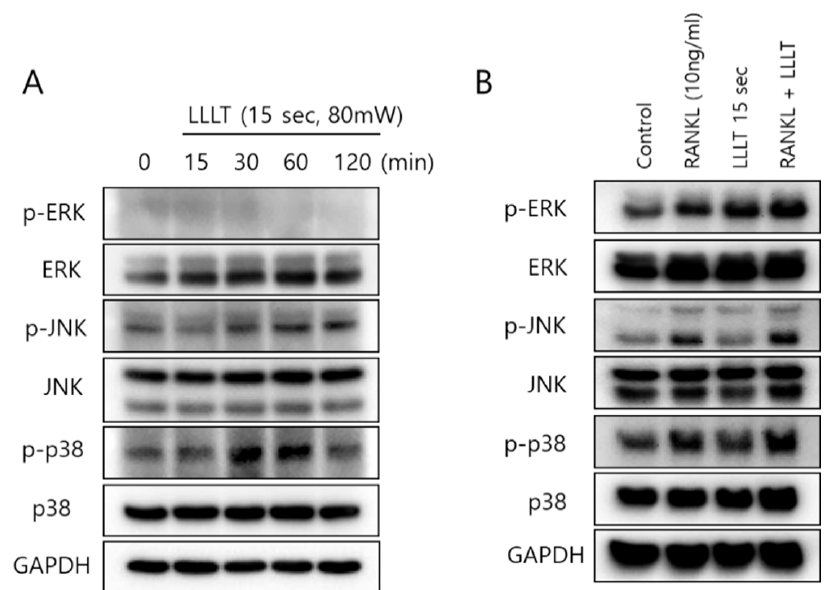
Figure 5. Effect of LLLT irradiation on the MAPK pathway in RAW 264.7 cells. ( A ) Only LLLT (15 Scheme 264.7 cells, and the change pattern of MAPK was confirmed for 15 to 120 min. ( B ) RAW 264.7 cells were pretreated with RANKL (10 ng/mL) and LLLT for 15 s and incubated for 24 h and the change in MAPK was confirmed.